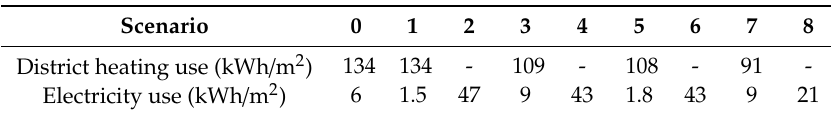
Table 4. Annual energy